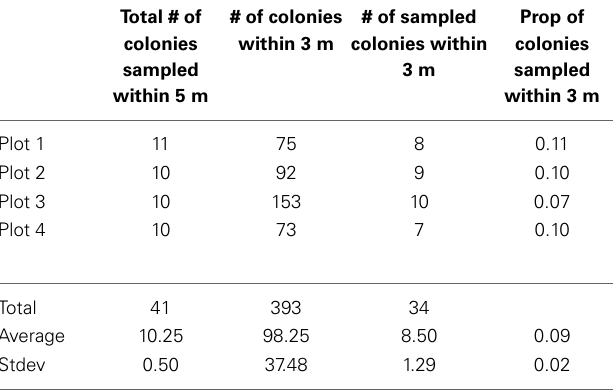
Table 2 | Pocillopora colonies in the Concha y Perla lagoon on Isabela Island, Galápagos Islands were sampled ( n = 41) in four plots of 5m